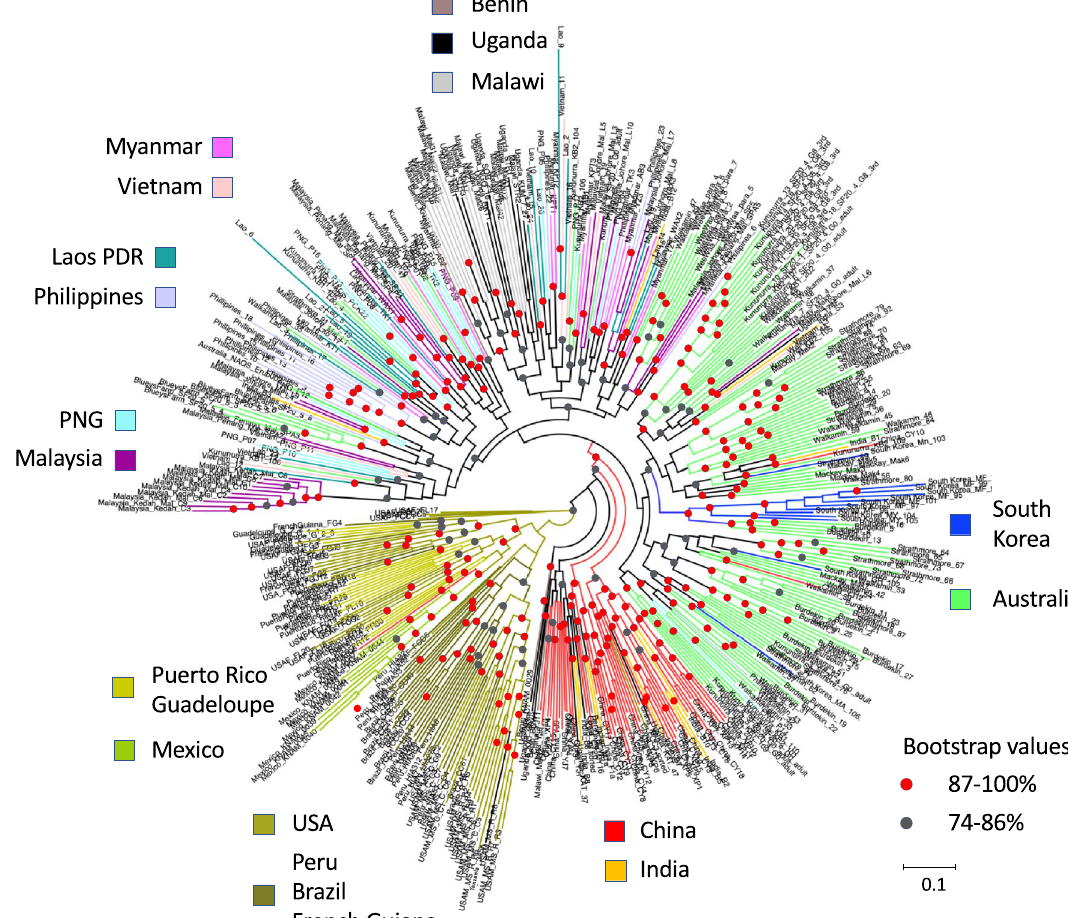
Figure 2. Maximum Likelihood (ML) phylogeny using 879 genome-wide non-coding SNPs with 1000 ultrafast (UF) bootstrap replications. Node support with < 74% are not shown, 74–86% are represented by grey circles, 87–100% are represented by red circles. Country of origin is colour